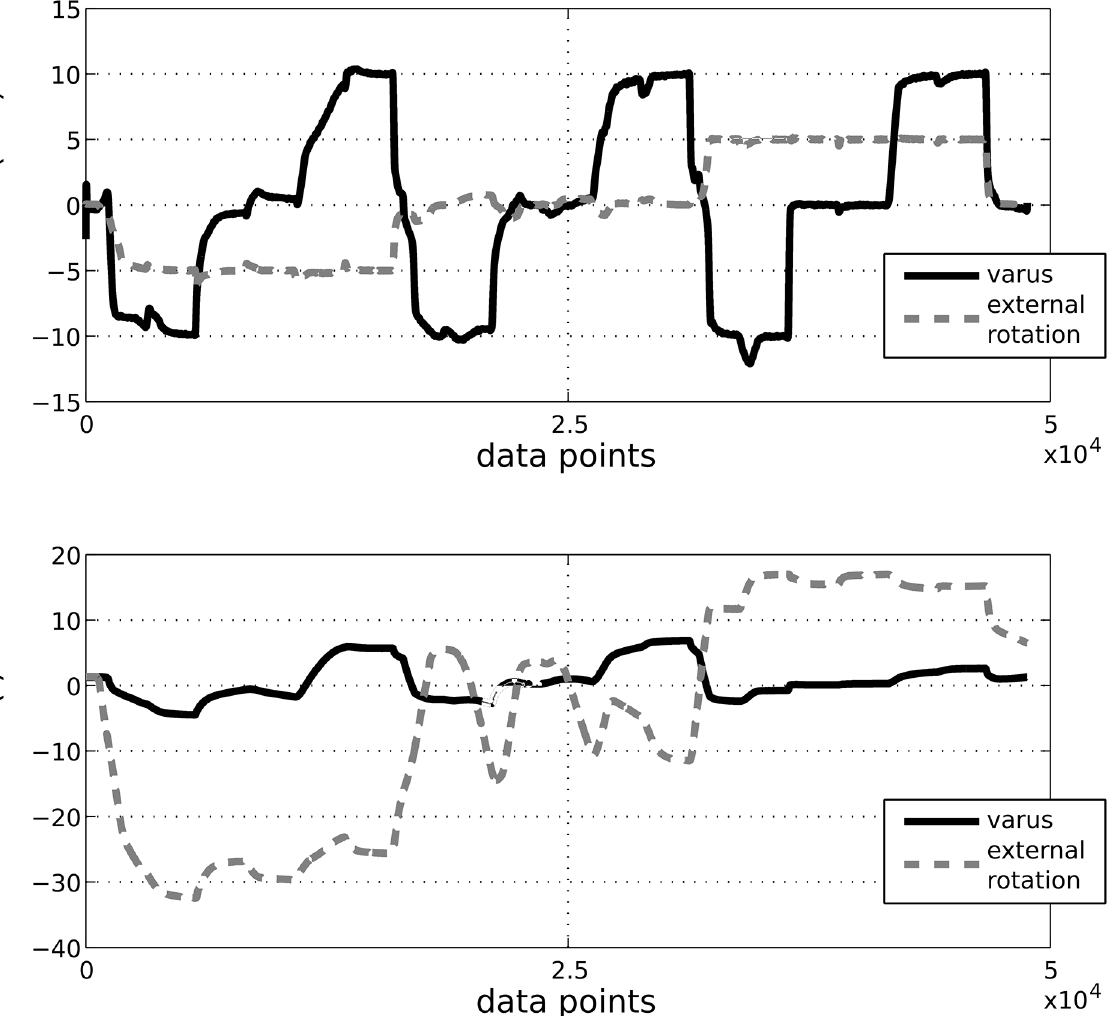
Fig 4. Time history of applied varus and external rotation moments and resulting joint rotations during combined loading. Tibiofemoral flexion was set at 30° during this particular test. The loads are represented in the tibia fixed coordinate system; movements are described in the anatomical joint coordinate